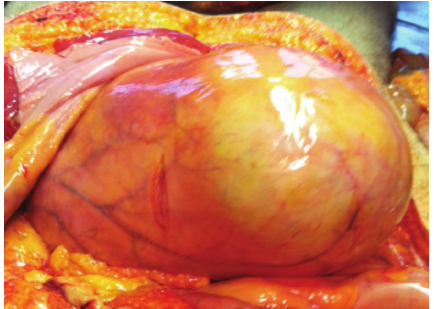
Figure 1: Chemical structures of clozapine and clotiapine.